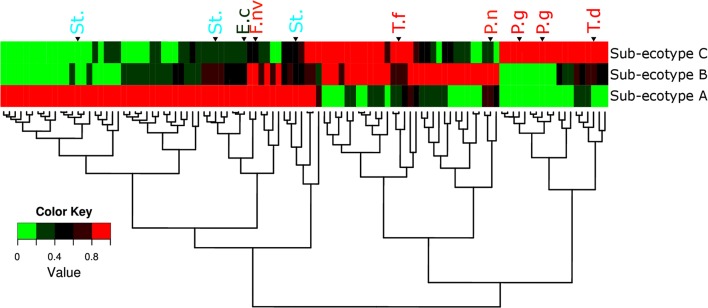
Microbiota’s structure divergence between the sub-ecotype A, B and C. Heatmap of the normalized abundance for the 106 OTUs differentially abundant between the three sub-ecotypes found by the LEfSe analysis. The abundance was normalized for each OTU by the maximal value observed among the sub-ecotypes to obtain a value ranking between 0 and 1. This normalization allows a good visualization of the differential abundance among the three clusters independently of the relative abundance. OTUs are in rows and clusters are in columns. The color key is shown on the lower left. The dendrograms show the relationship between the three sub-ecotypes based on the Bray–Curtis distance. OTUs are named by their taxonomic assignment and color coded depending of their membership to the red (in red), orange (in orange), green (in green), and yellow (in blue) complex define by Socransky. For an extensive view of all the OTUs, see the expanded version of this figure in Supplementary Figure S3. OTUs are clustered regarding their patterns of evolution among the three sub-ecotypes. P.g, Porphyromonas gingivalis; T.d, Treponema denticola; T.f, Tannerella forsythia; P.n, Prevotella nigrescens; St., Streptococcus sp.; F.nv, Fusobacterium nucleatum vincentii; E.c, Eikenella corrodens.